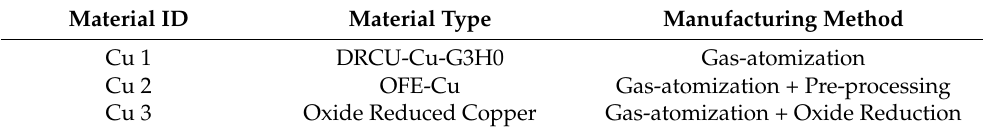
Table 1. Feedstock powder material details.